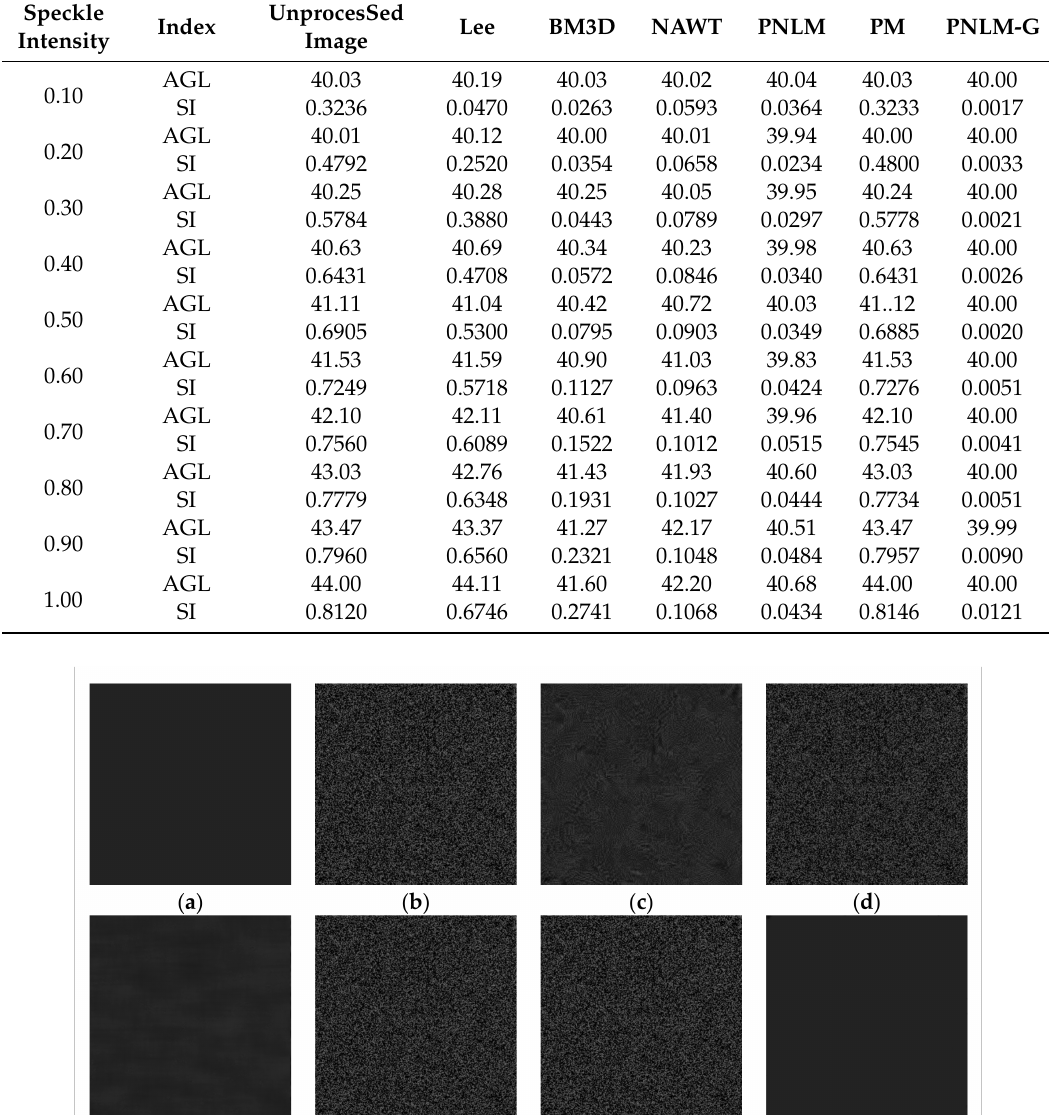
Table 1. Data statistics of ten pictures.